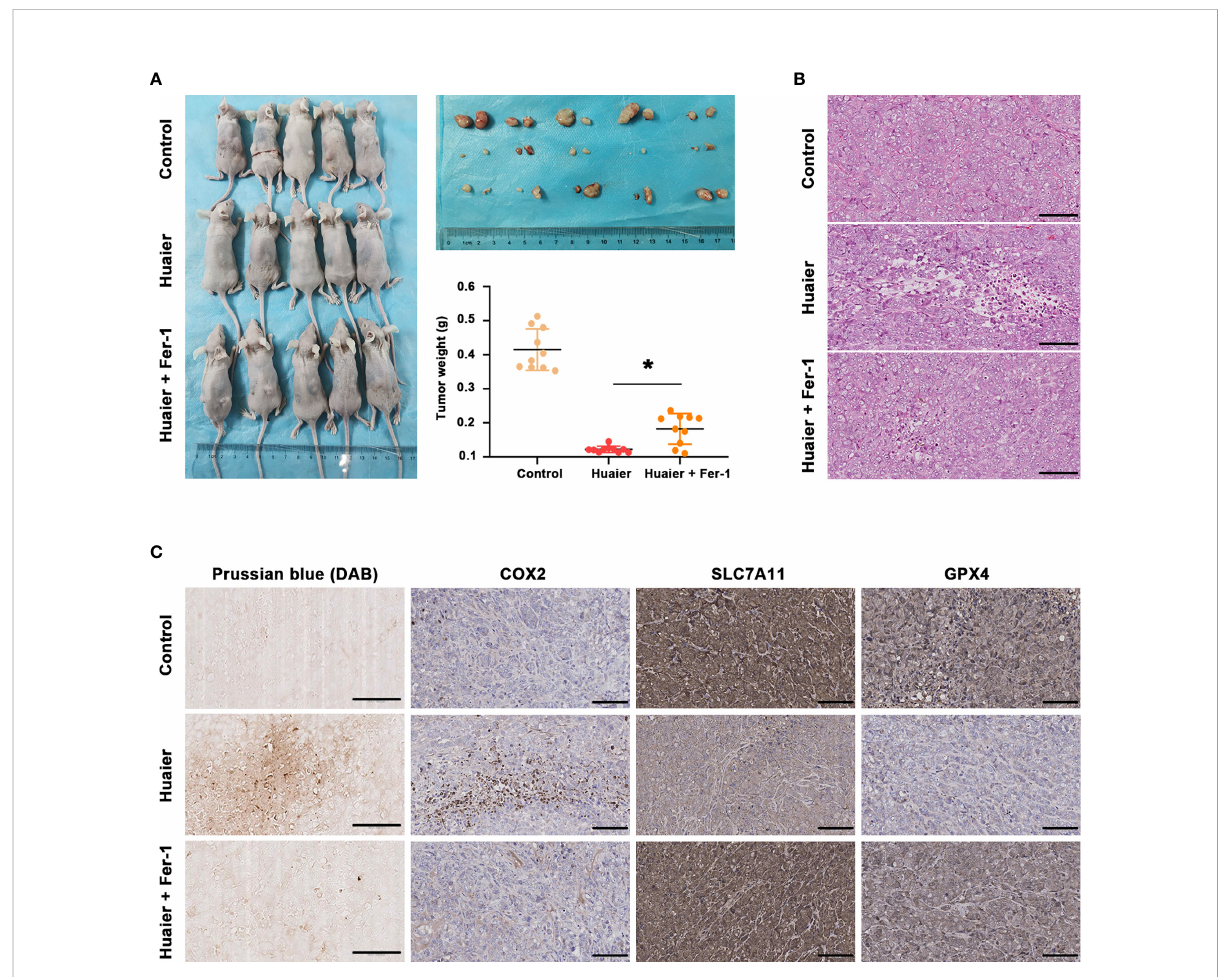
FIGURE 3 Huaier inhibited pancreatic cancer tumour growth in vivo by inducing ferroptosis. (A) Macroscopic images of pancreatic cancer tumours in the control, Huaier and Huaier plus ferrostain-1 (Fer-1) groups and statistical graph of their tumour weights. (B) H&E staining showed the micropathological morphology of pancreatic cancer tumours in the control, Huaier and Huaier plus Fer-1 groups. (C) Prussian blue staining and IHC staining of COX2, SLC7A11 and GPX4 in pancreatic cancer tumours in the control, Huaier and Huaier plus Fer-1 groups. *P < 0.05, scale bar = 100 m